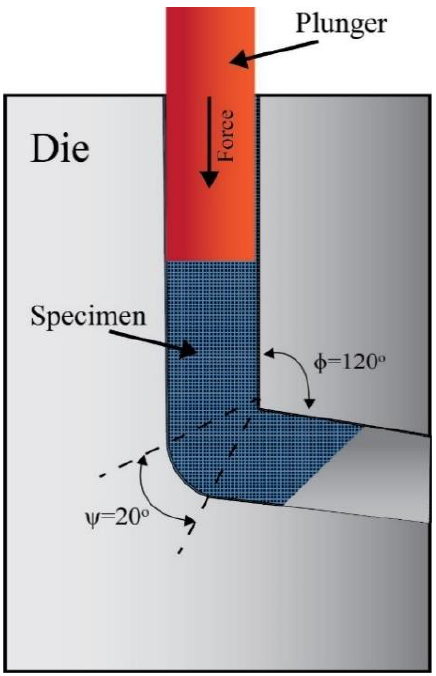
Figure 1. The schematic of the equal channel angular pressing (ECAP) die [25]. niques to analyze engineering problems [39,51]. The deformation process, strain and stress distribution, metal flow and simulated relation between the processing load and plunger displacement plots during ECAP processing can be obtained using FE [52,53].